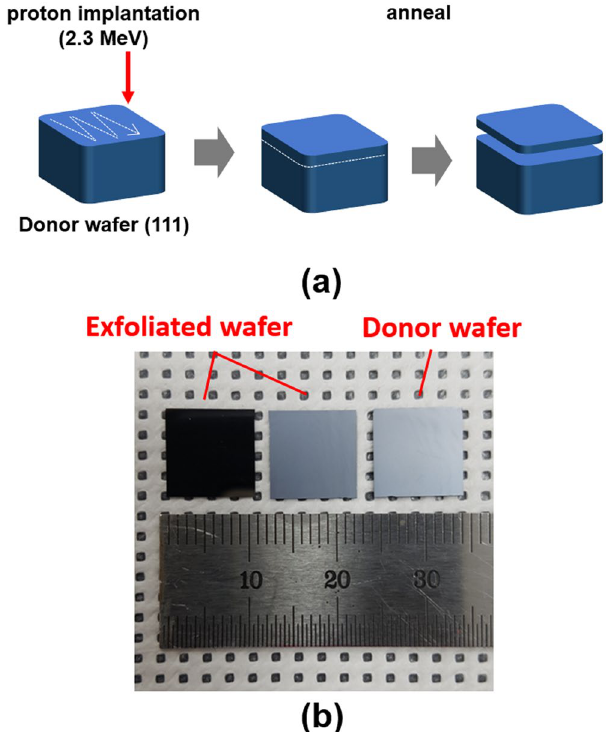
Figure 1. ( a ) Illustrations of the proton induced exfoliation process steps for kerfless wafering. ( b ) The photograph images of exfoliated wafers and a donor wafer. The left wafer is an exfolidated one with the cleaved surface facing down. The wafer in the center is an exfoliated one with the cleaved surface facing up. The righ wafer is an donor wafer with the cleaved sufrace facing